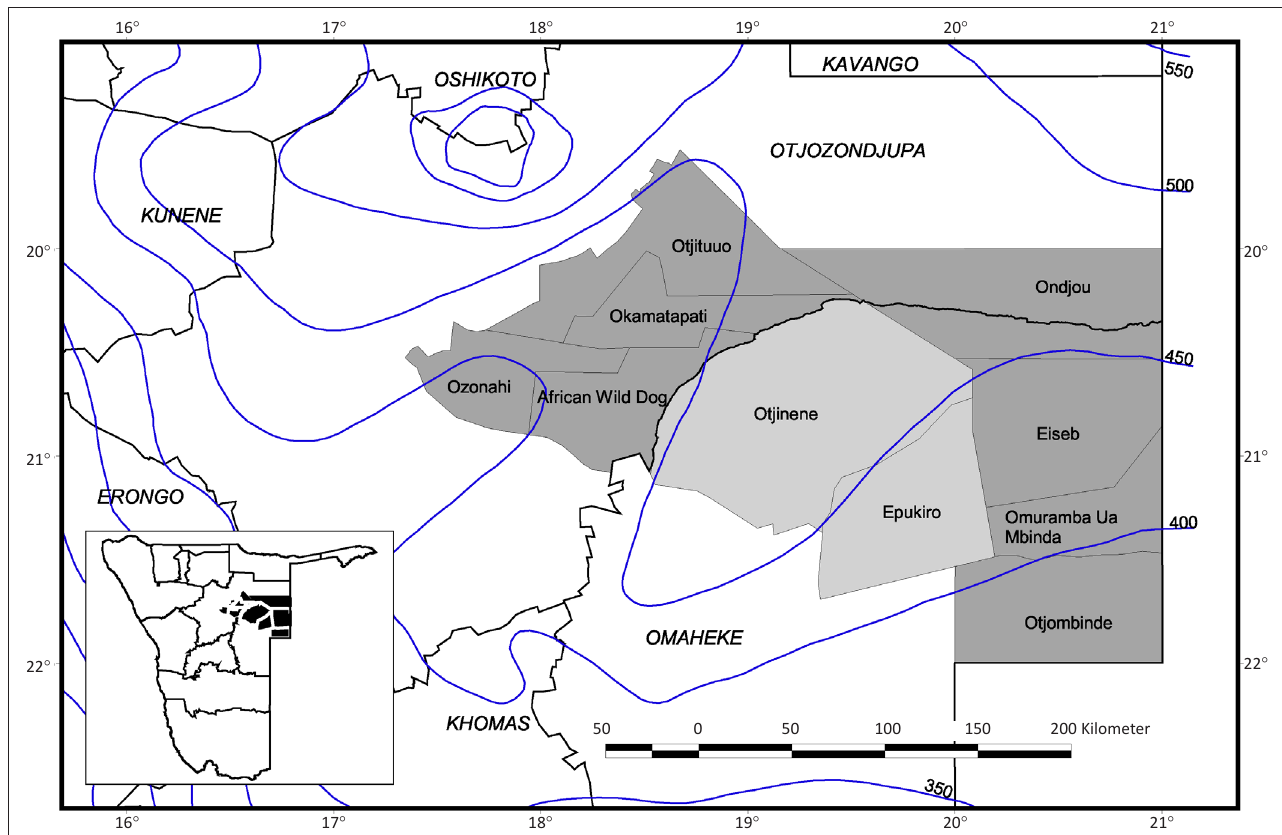
FIGURE 1: Overview map of the communal conservancies within the Omaheke and Otjozondjupa regions in Namibia. The average annual rainfall is indicated by the isohyets, with their values in millimetres, indicated on the right.